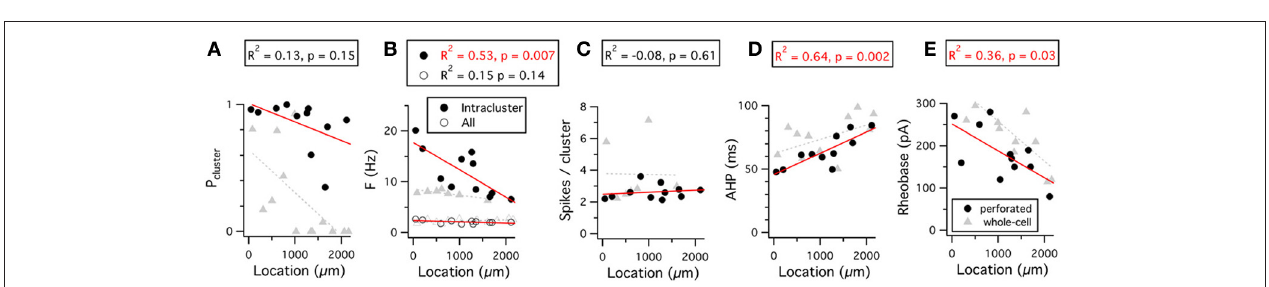
FIGURE 9 | Dorsal-ventral organization of firing properties. (A–E) Probability that a spike is part of a cluster (A) , frequency of spikes throughout the 15s duration analysis window (open circles) or within a cluster (closed circles) (B) , number of spikes per cluster (C) , duration of the action potential after-hyperpolarization (D) , and rheobase (E) , are plotted as a function of the location of the recorded neuron. Data analyzed were from 5s to 20s after the onset of the current steps that